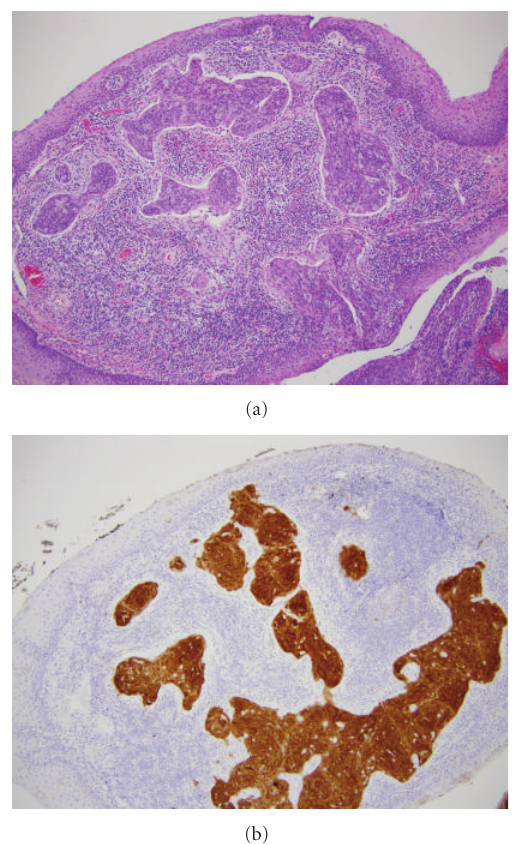
Figure 4: (a) Hematoxylin and eosin stained section of the left tonsil showing invasive squamous cell carcinoma, magnification 100X (b) Immunohistochemical stain for p16 performed on a serial section, magnification